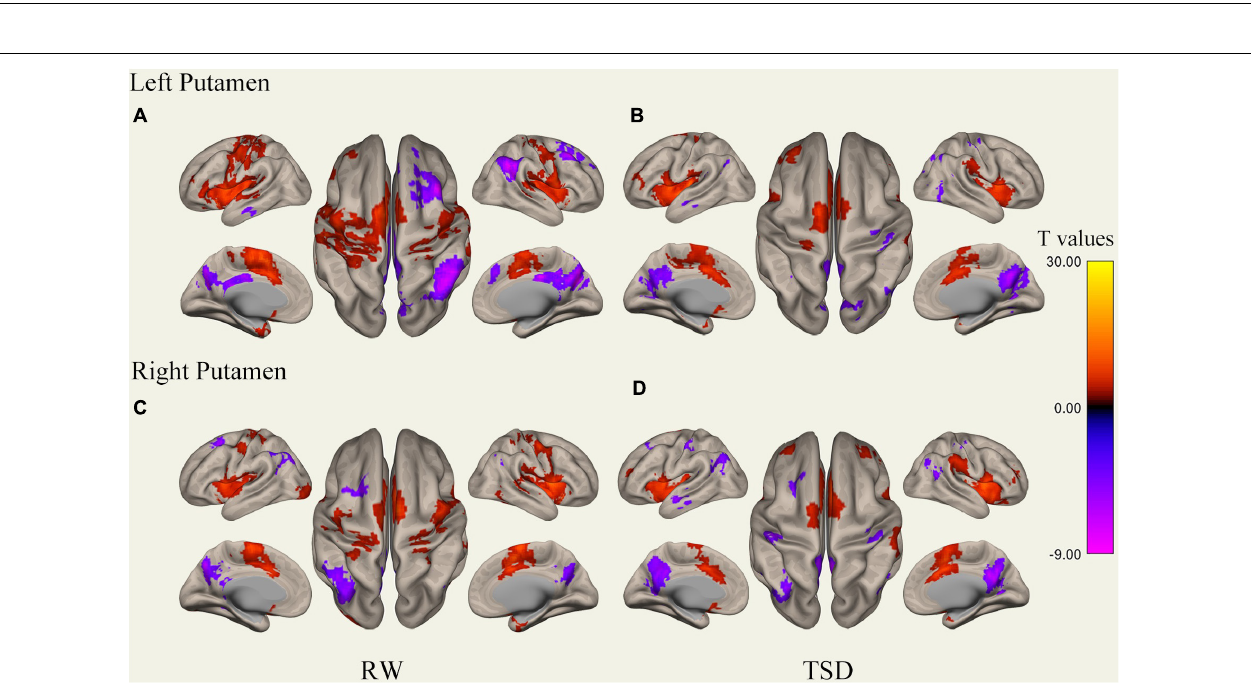
FIGURE 2 | Whole-brain functional connectivity patterns of the putamen before 36 h TSD shown at panels (A,C) , and after 36 h TSD shown at panels (B,D) ( n = 30) (Surface view). Warm colors indicate positive correlations, and cold colors indicate negative correlations.